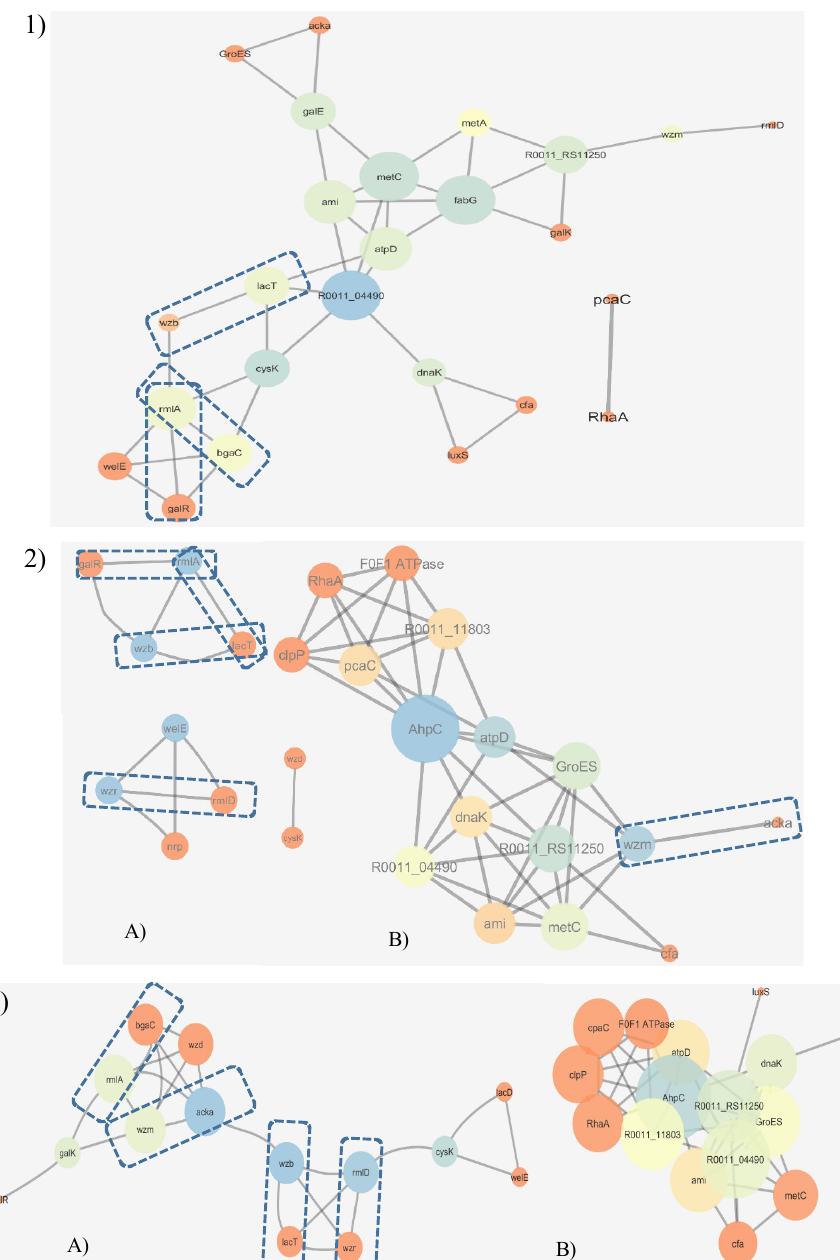
Figure 5. Co-expression gene network of L. rhamnosus strains R0011 ( 1 ); ATCC 9595 ( 2 ) and RW-9595M ( 3 ) obtained using Cytoscape 3.4. The illustrated genes had a significant ( P < 0.05) strong correlation (correlation index > 0.8). The largest nodes (circle size) are those with the high level of degree. In the above figure, the blue nodes had higher values of Betweenness Centrality (BC) and the orange nodes had lower BC values. Non-continuous traits show a co-expression pattern found for the three strains of L. rhamnosus R0011, ATCC 9595 M, and RW-9595M.